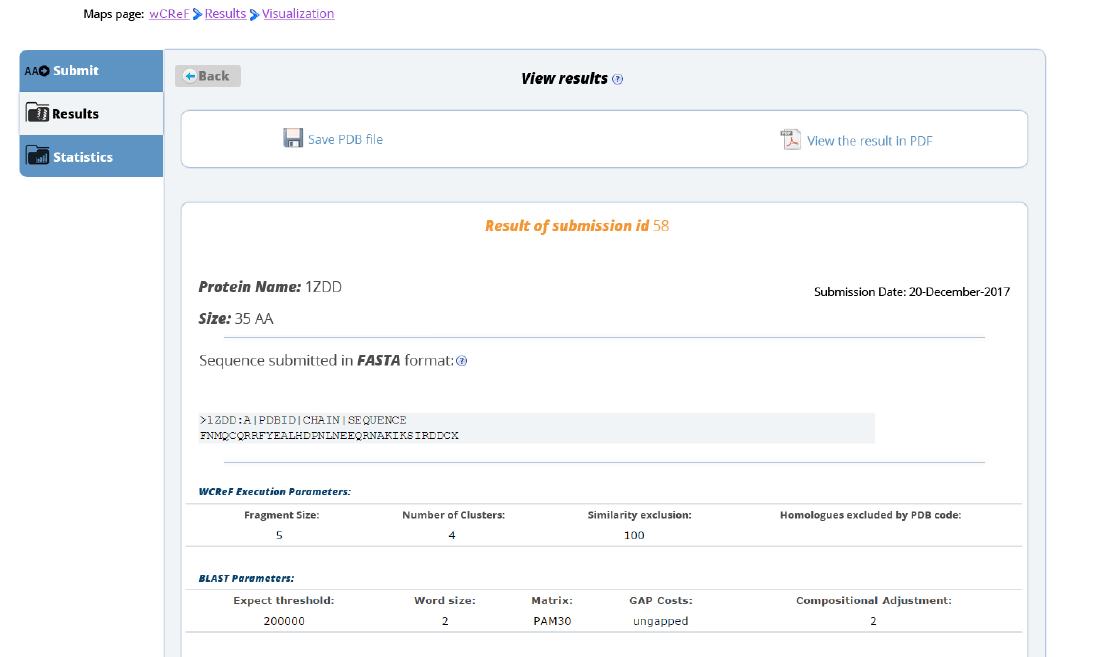
Figure 7. wCReF results page. The first part shows the submission parameters as sent by the user.